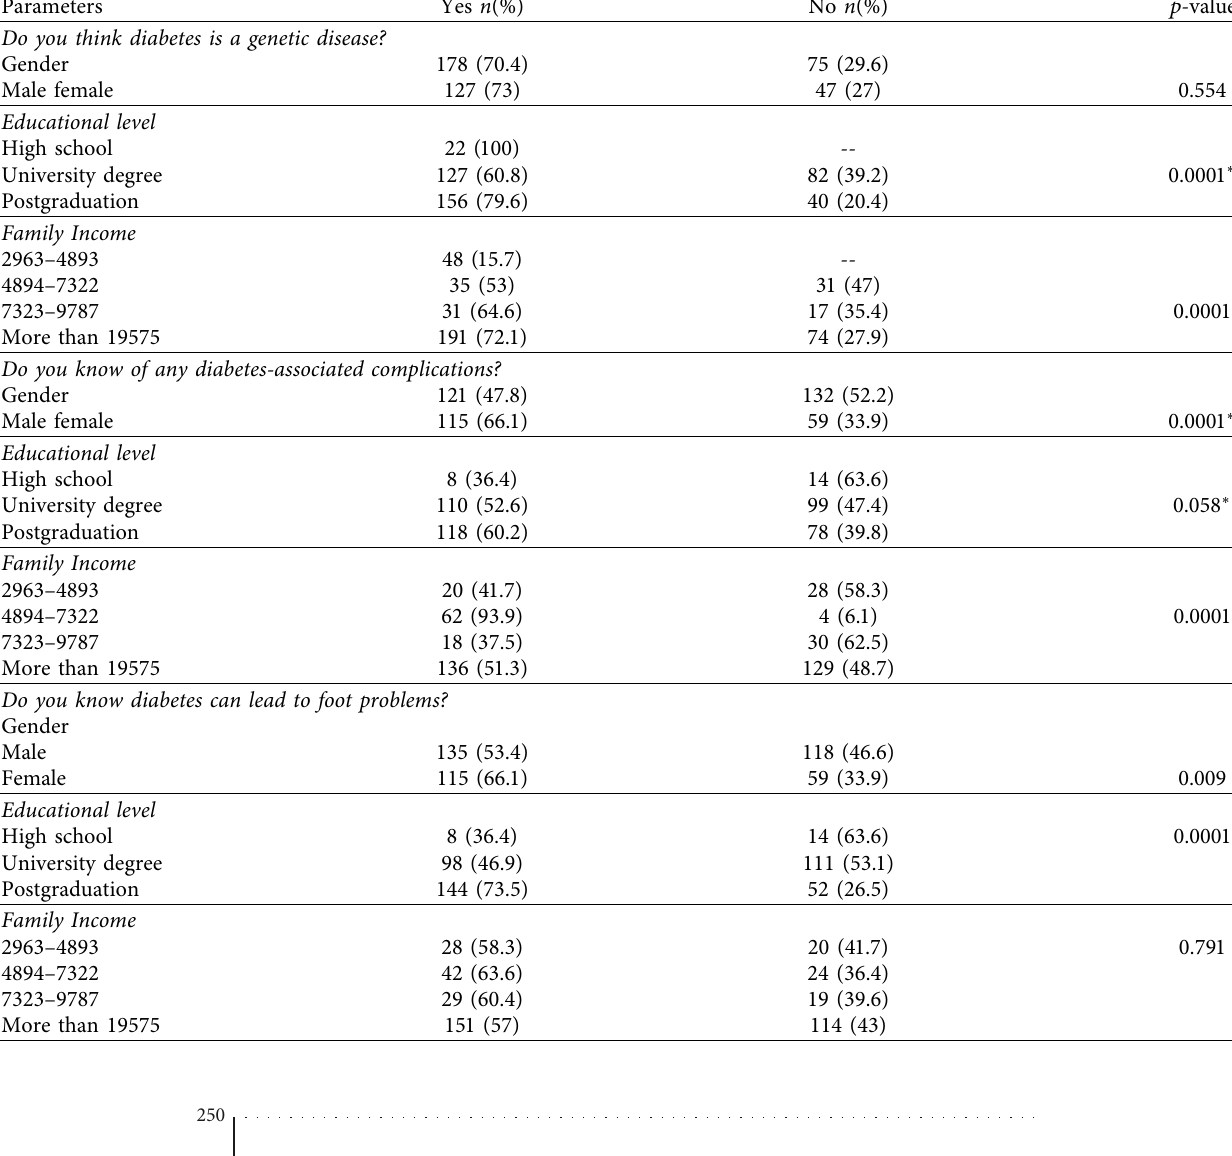
Table 3: Diabetes knowledge parameters and their association with demographics.